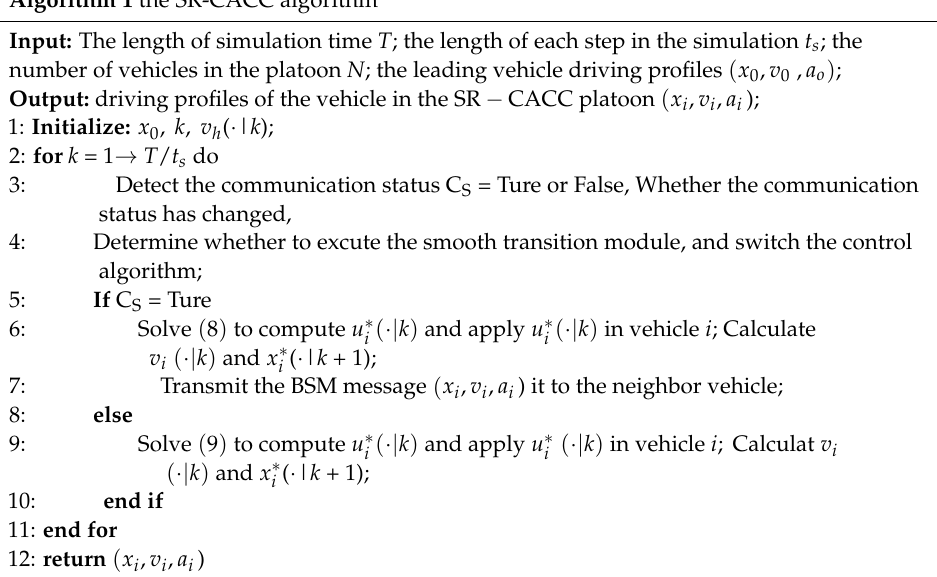
Algorithm 1 the SR-CACC